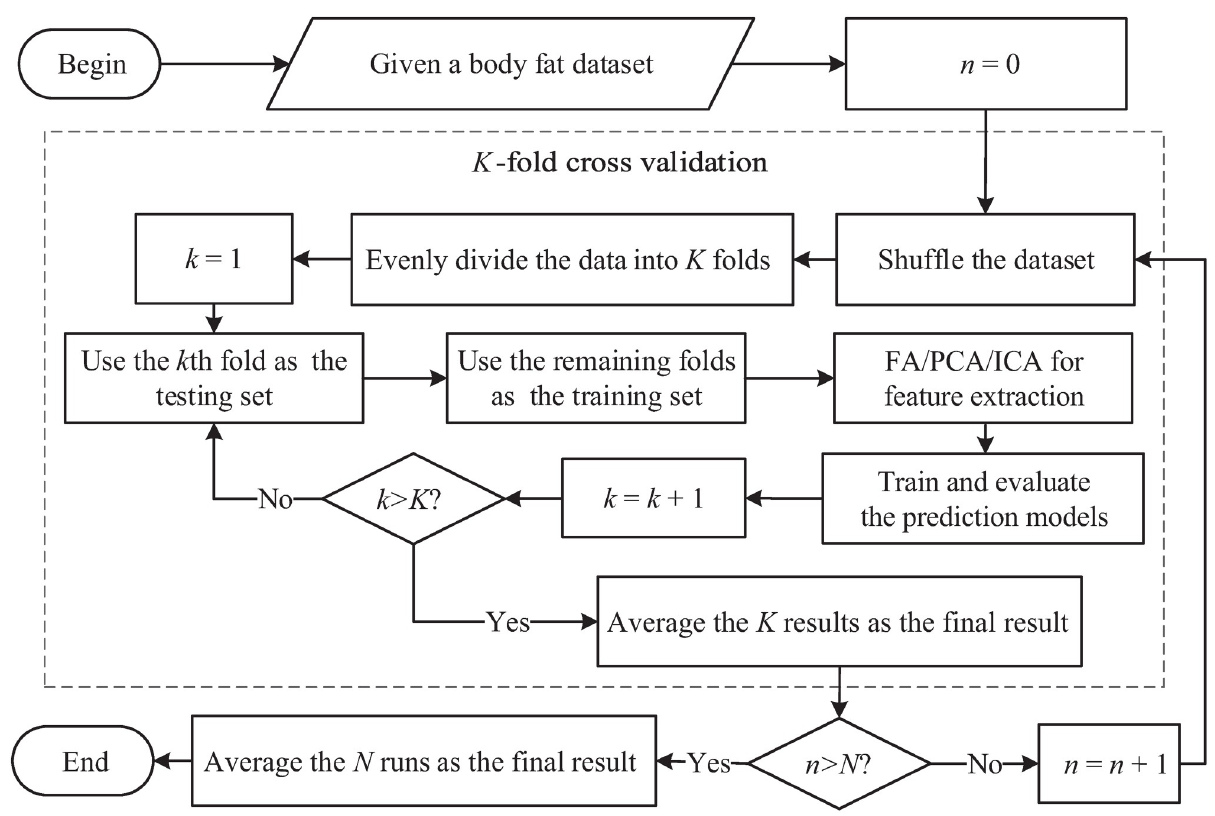
Fig 8. A flowchart of different feature extraction methods used for body fat prediction based on K -fold cross validation with N repeated experiments.